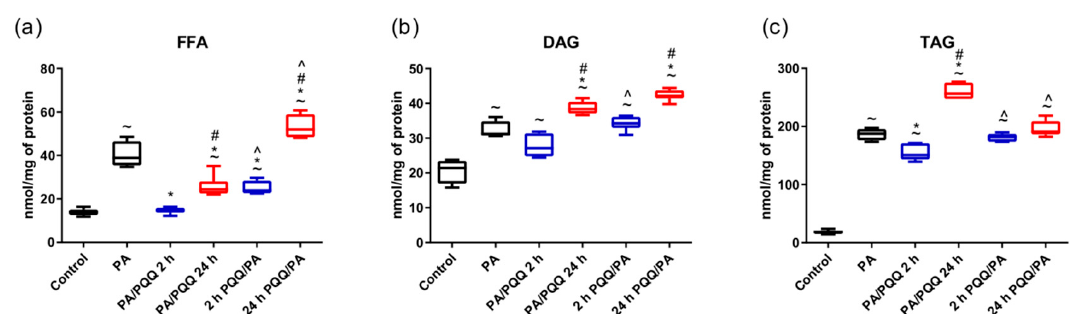
Figure 1. Effects of short- and long-time incubation with pyrroloquinoline quinone (PQQ) on the intracellular content of ( a ) free fatty acids, ( b ) diacylglycerols, and ( c ) triacylglycerols in L6 myotubes. The values are presented as mean ± SEM and are based on six independent determinations. The Kruskal–Wallis test followed by post hoc adjustment was applied. ~ p < 0.05, study groups versus control; * p < 0.05, PQQ-incubated groups versus palmitate group; # p < 0.05, time-dependent differences (long- vs. short-time incubation with PQQ); ^ p < 0.05, sequence-dependent differences (pre-incubation with PQQ vs. post-incubation with PQQ). ANOVA: analysis of variance; PA: palmitic acid; PQQ: pyrroloquinoline quinone.